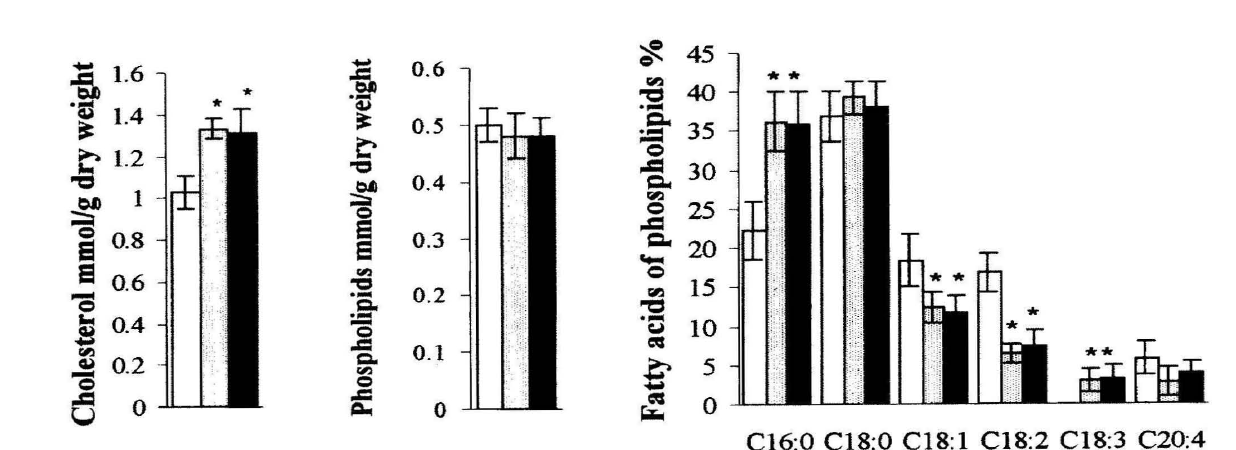
Figure 1. Concentrations (mean±S.D.) of cholesterol and phospholipids, as well as fatty acid content (in percent: mean ± S.D.) in controls (open bars) and in samples with 5 pmol/g wet weight D - neopterin (dotted bars) and 30 pmol/g wet weight D-neopterin (hatched bars). Samples of rat liver tissue homogenates were used to test for phos pholipid biosynthesis in vitro. Incubation medium: Krebs-Ringer-phosphate buffer, containing 0.3% albumin (pH=7.4 ), fatty acid mixture and glycerol. Samples were incubated twice for 4 h at 37"C. *The changes are statistically significant (p<O.Ol-p<O.OO 1 ). Pteridines/ Vol. 9 / No.